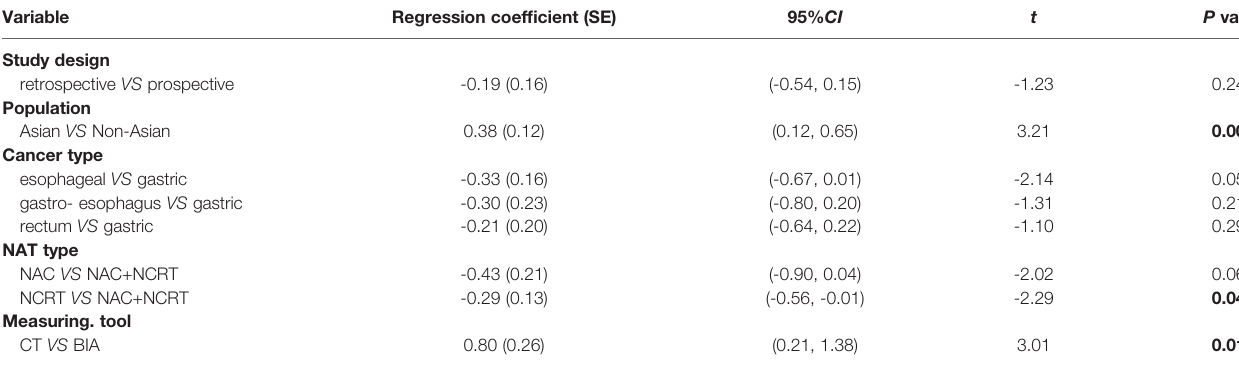
TABLE 5 | Results of multiple meta regression for potential source of heterogeneity.